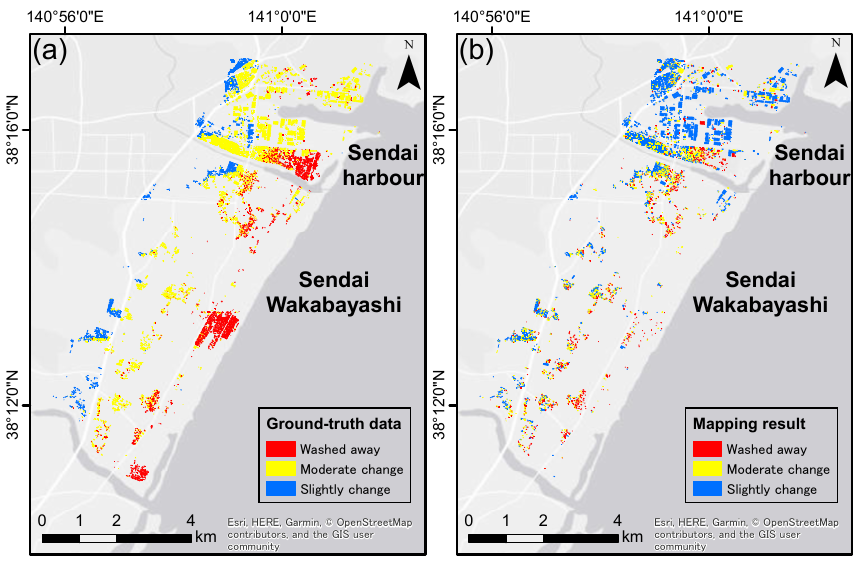
Figure 9. Mapping result of Scheme 4: ( a ) ground truth data; and ( b ) mapping